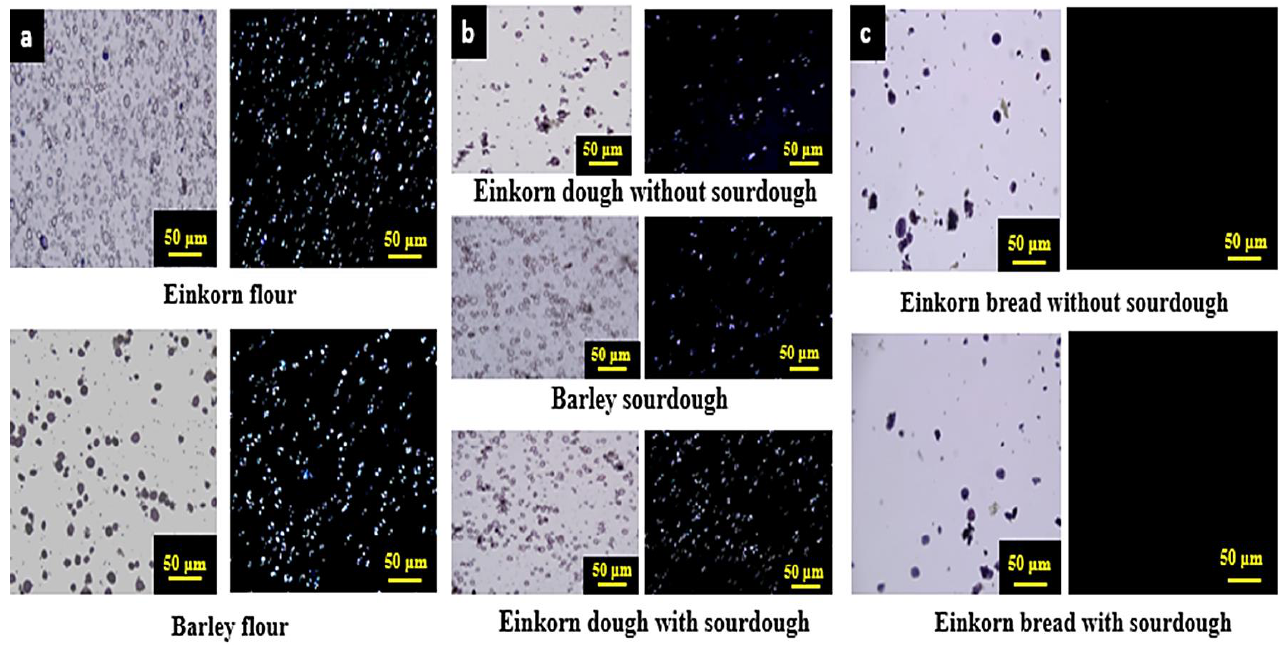
Figure 8. Optical micrographs of starch granules from einkorn and barley flours ( a ), barley sourdough and einkorn dough with and without sourdough ( b ), and crumb of einkorn fresh bread with and without sourdough ( c ), stained by iodine solution and observed under bright-field light (left pictures) and cross-polarised light (right pictures).